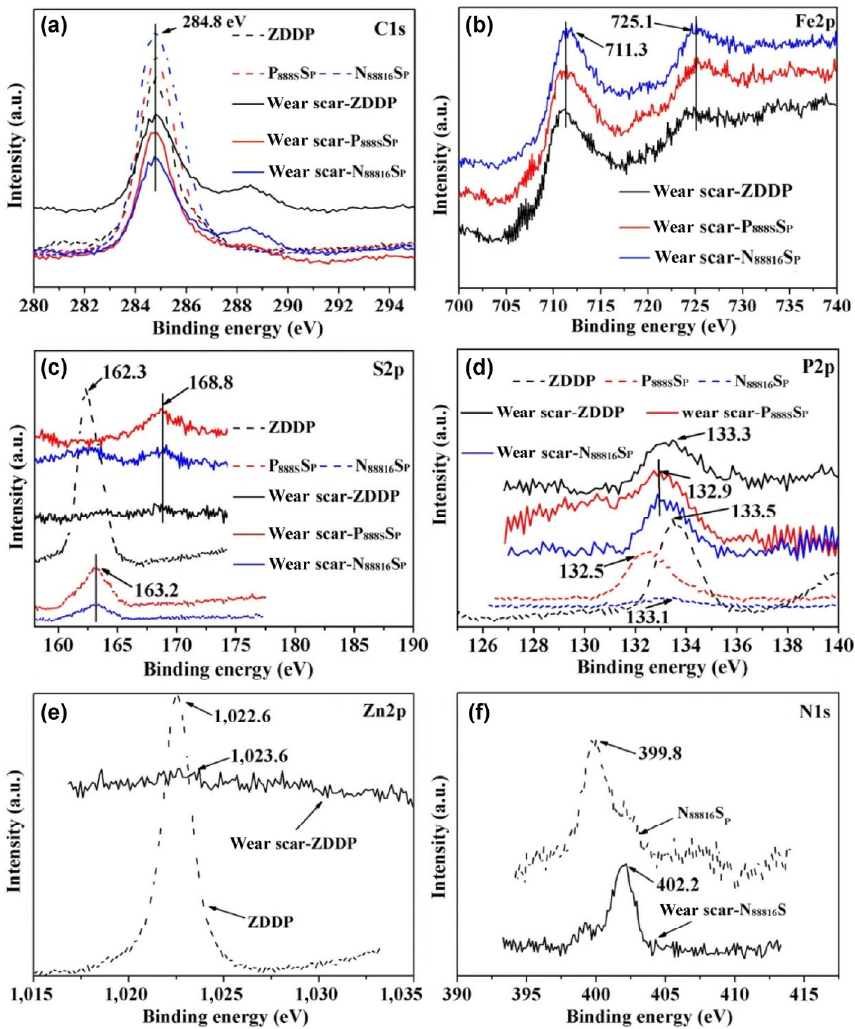
Fig. 11 XPS spectra of (a) C1s, (b) Fe2p, (c) S2p, (d) P2p, (e) Zn2p, and (f) N1s of neat lubricants and corresponding wear scars lubricated by 1 wt% ZDDP, 1 wt% P 888S S P , and 1 wt% N 88816 S P respectively, at 300 N, 25 Hz, and